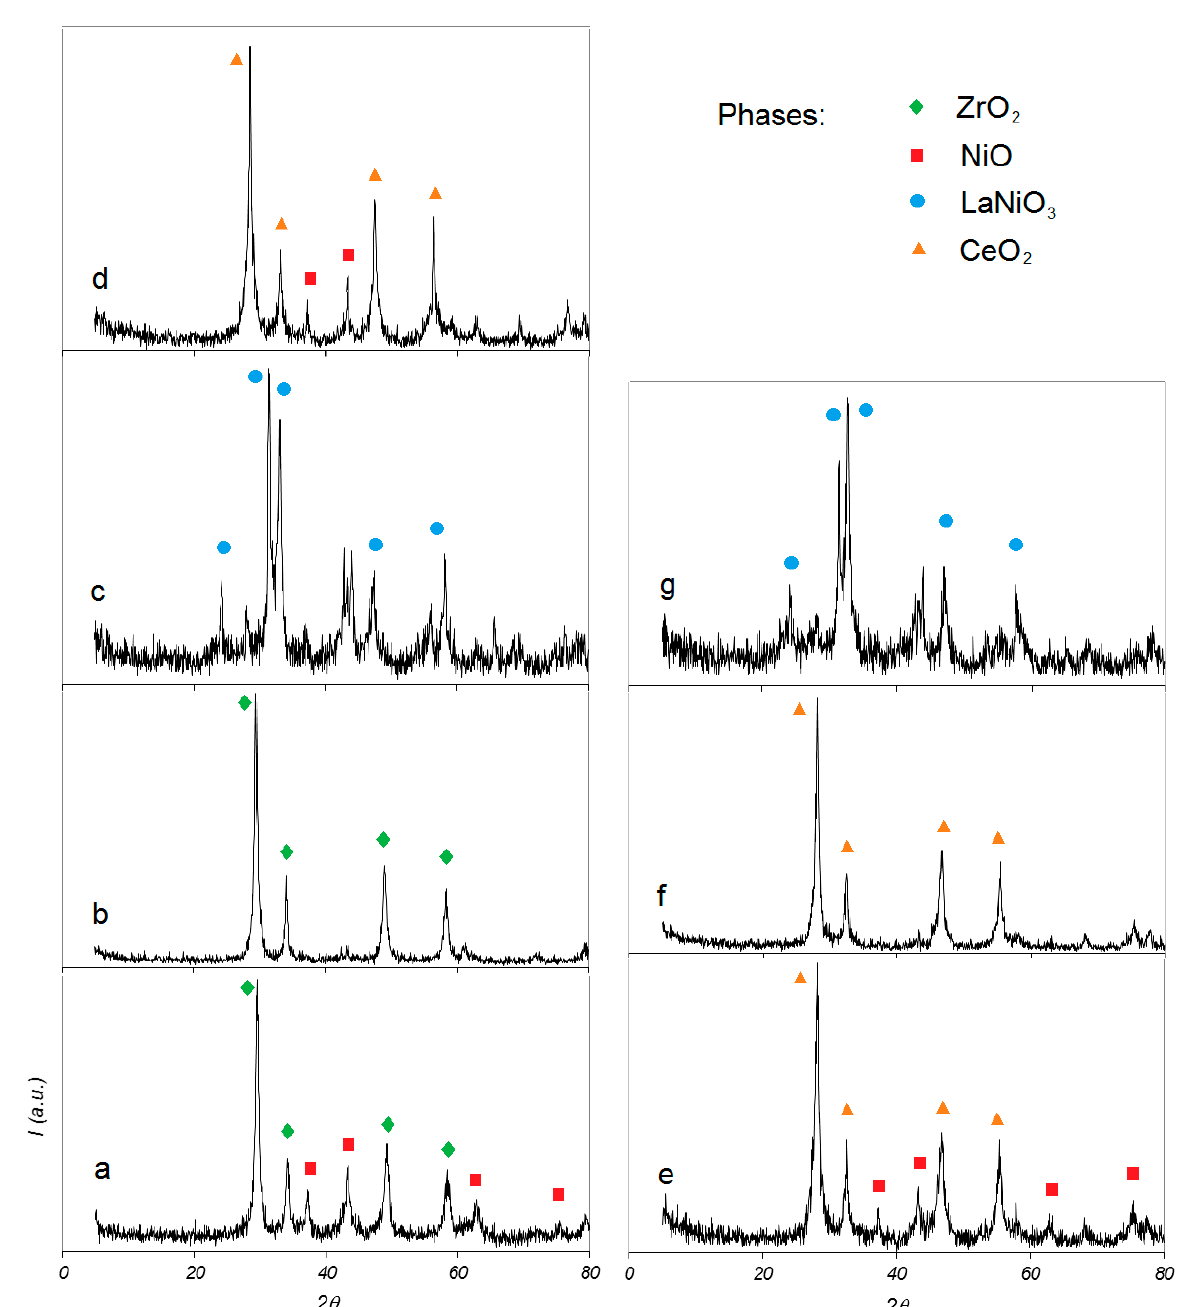
Figure 4. XRD patterns of the flame spray pyrolysis (FP)-prepared catalysts.( a ) La 0.3 Zr 0.7 NiO 3 ; ( b ) 10 wt% Ni/(0.3La 2 O 3 – 0.7ZrO 2 ); ( c ) La 0.8 Sr 0.2 NiO 3 ; ( d ) CeNiO 3 ; ( e ) La 0.3 Ce 0.7 NiO 3 ; ( f ) 10 wt% Ni/(0.3La 2 O 3 –0.7CeO 2 ); ( g ) LaNiO 3 .